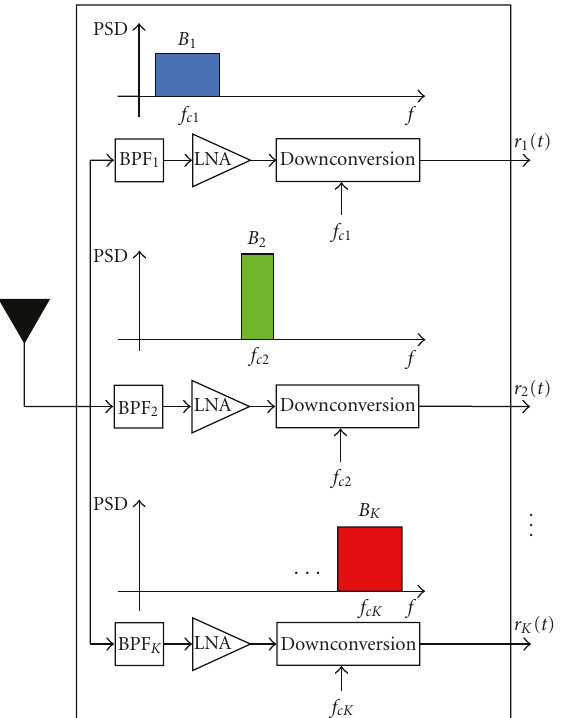
Figure 2: Block diagram of the front-end of a cognitive radio receiver, where BPF and LNA refer to band-pass filter and low-noise amplifier,